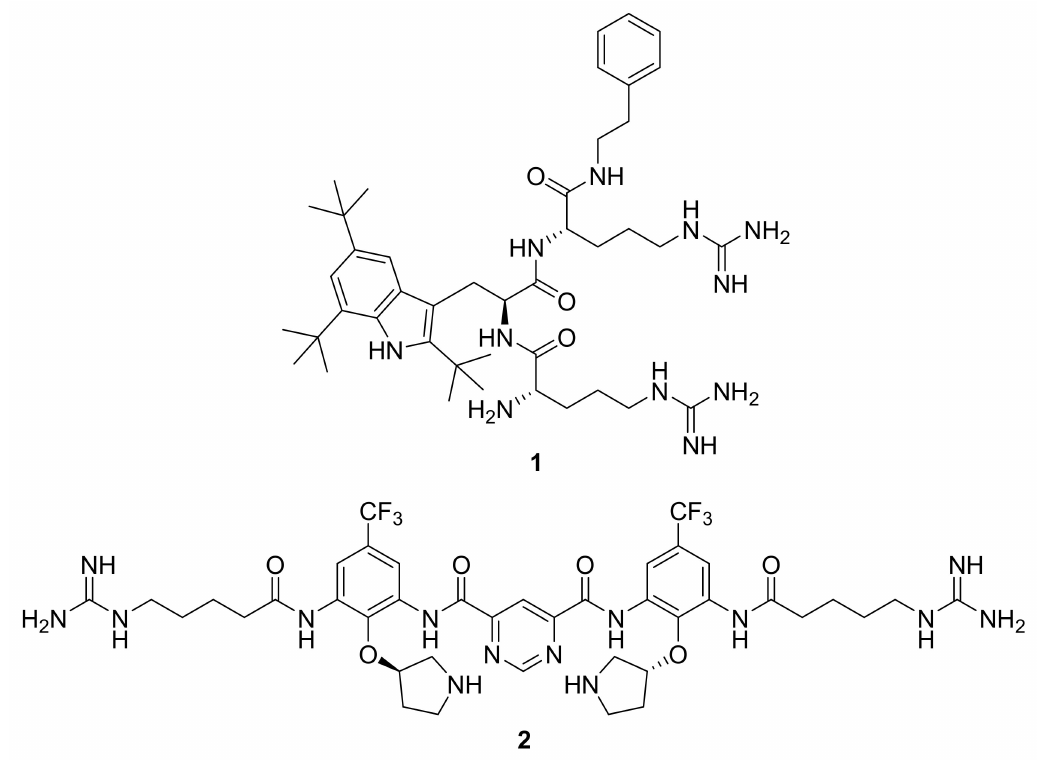
Figure 1. Structures of Lytixar (LTX-109) 1 and Brilacidin (PMX-30063) 2 .